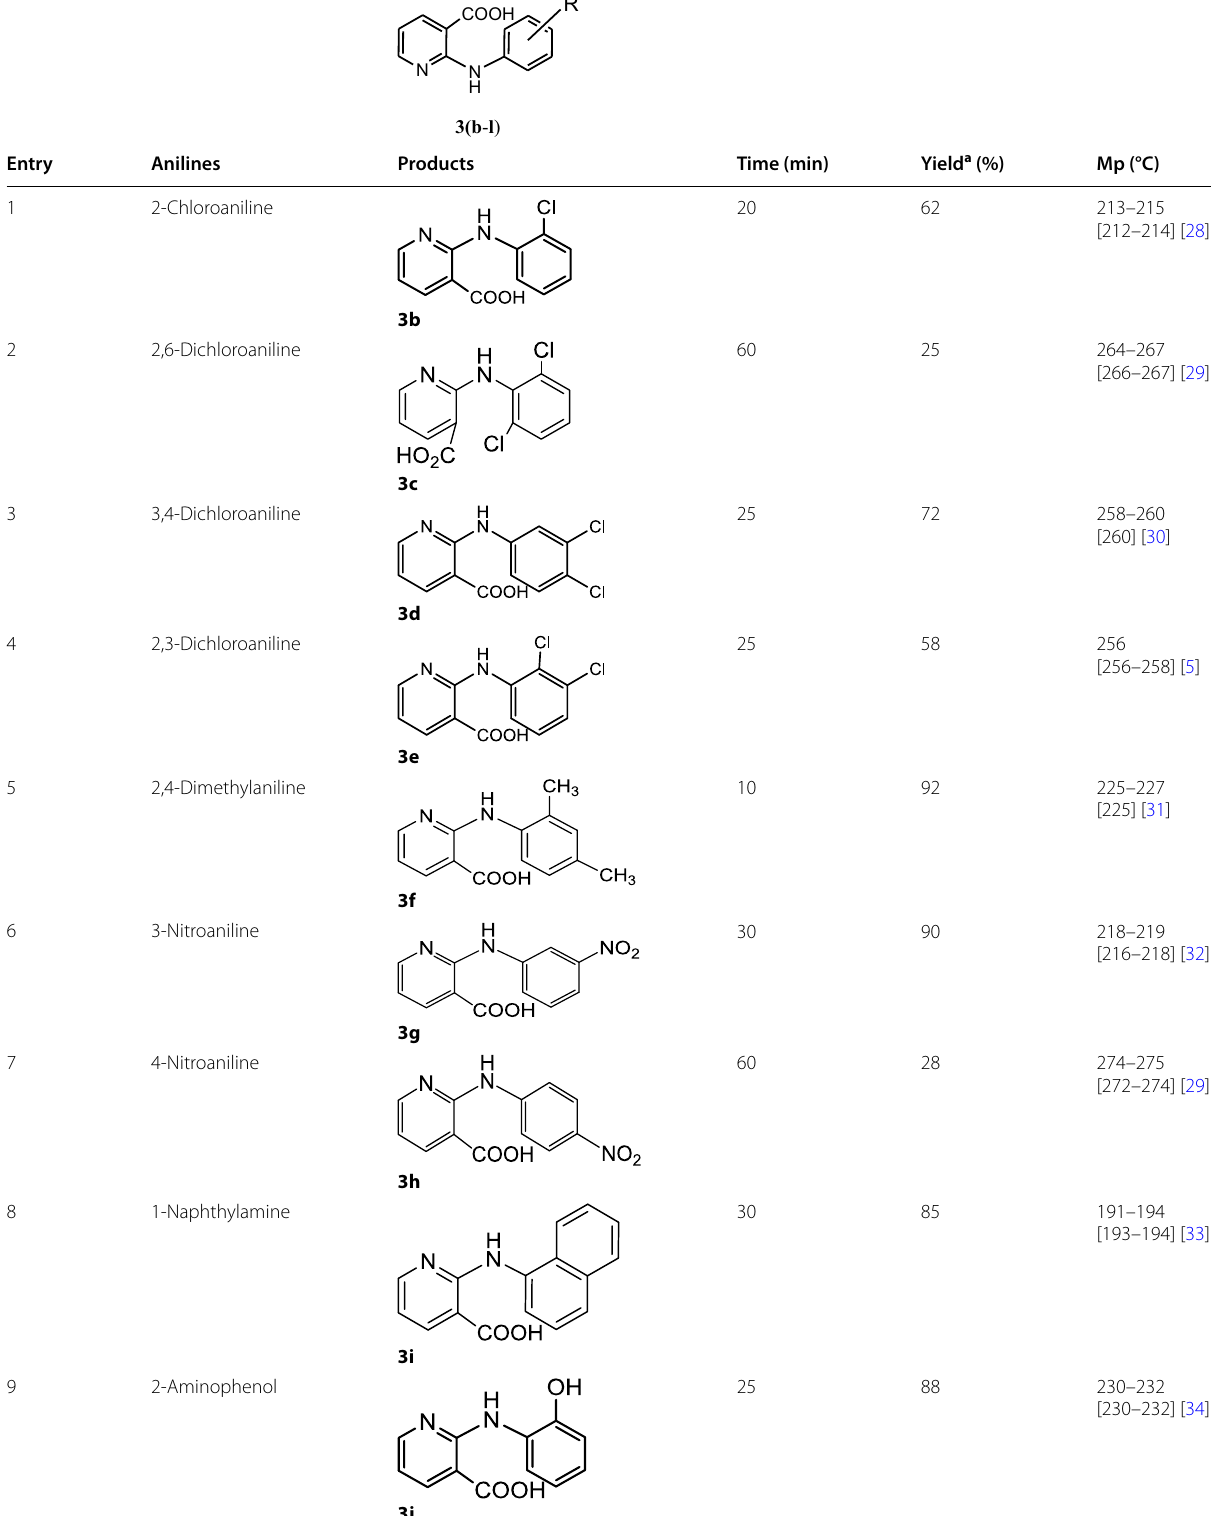
Table 2 Results of the synthesis of 2-arylaminonicotinic acids derivatives 3(b–l) under solvent-free